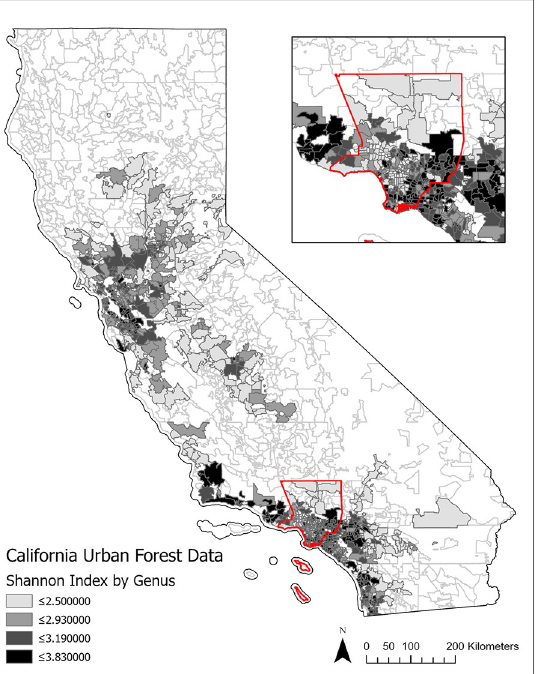
Fig 1. Variation in Urban tree diversity in California. Notes: Data for 857 zip codes in Heart Disease sample California from consortium of private tree maintenance companies.